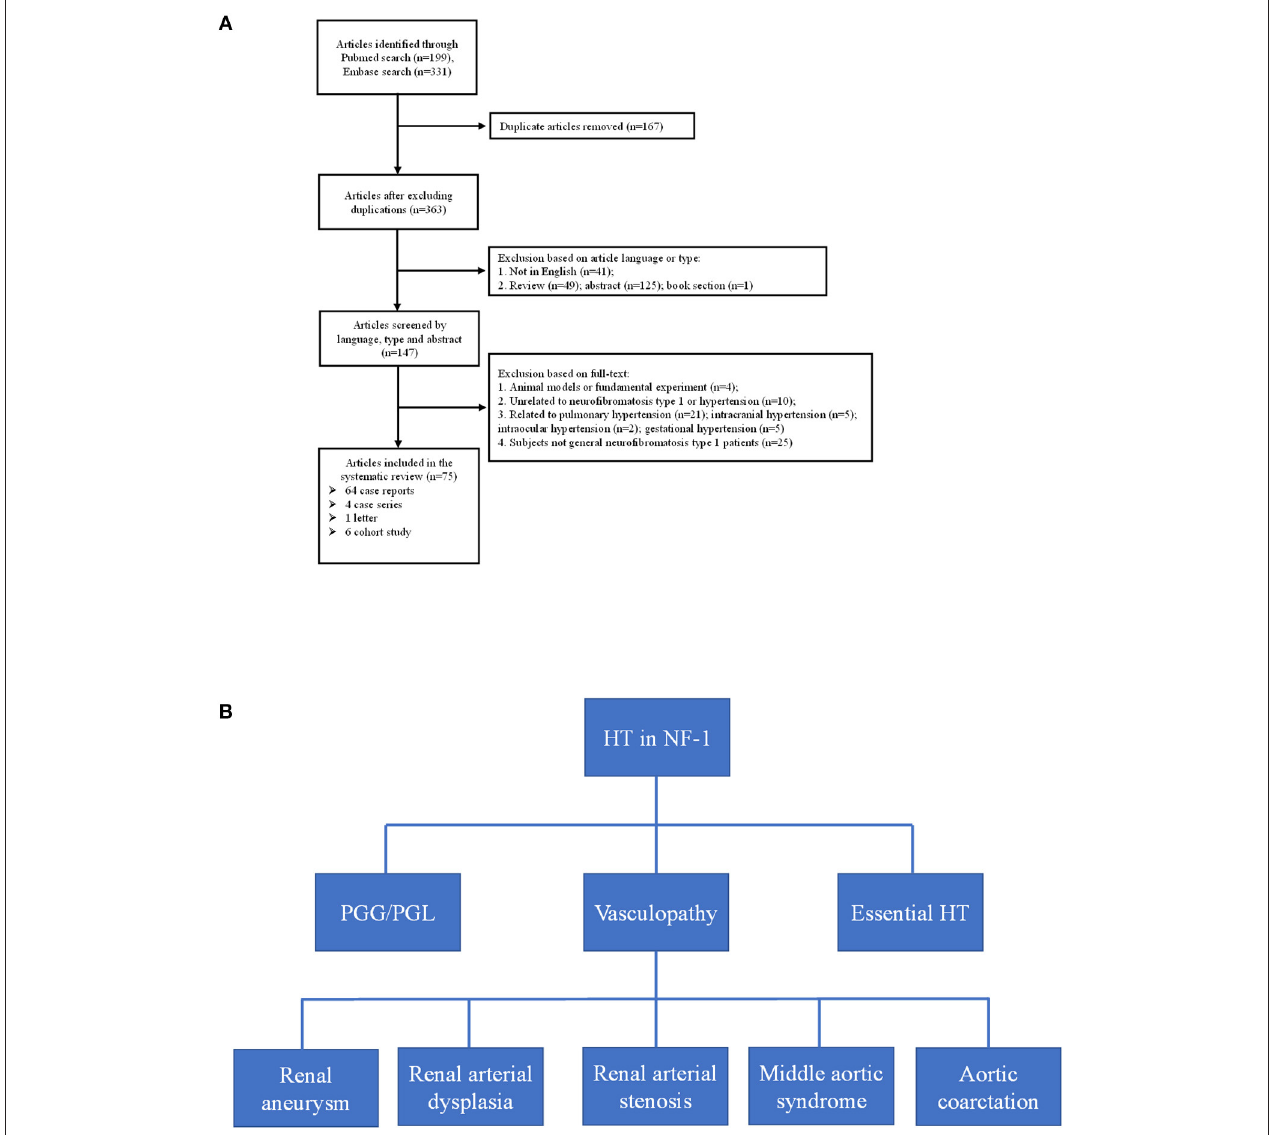
FIGURE 4 | (A) Flow-chart of the eligible articles extraction. (B) Etiologies of neurofibromatosis type 1 with hypertension. HT, hypertension; PGG/PGL, pheochromocytoma/paraganglioma.